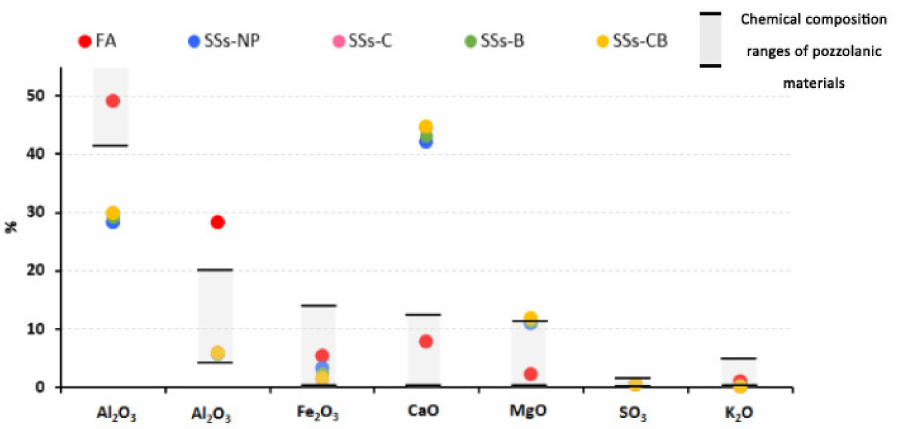
Figure 3. Chemical composition of FA and SSS in relation to ranges established for pozzolanic